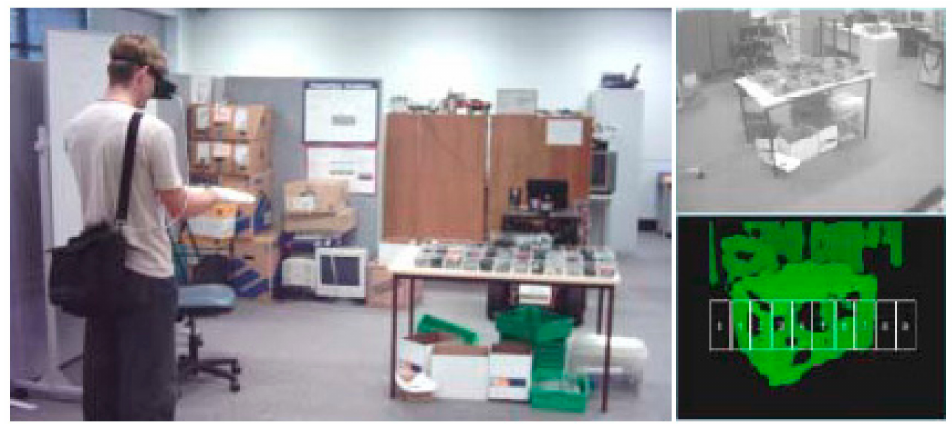
Figure 3. The ENVS